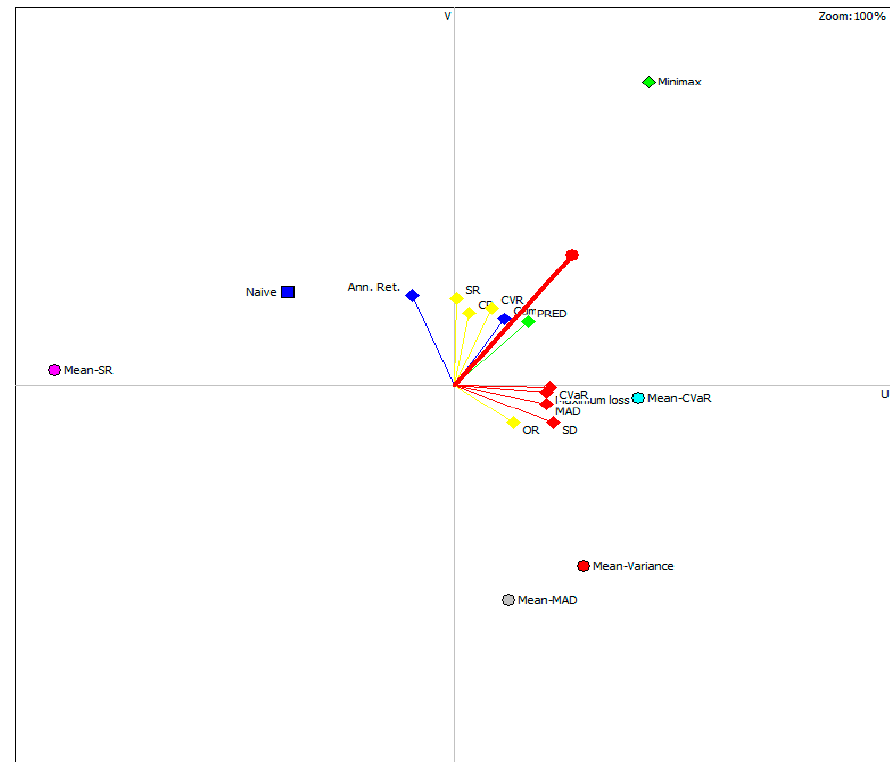
Figure 6. GAIA Plane. Table 4. Stability